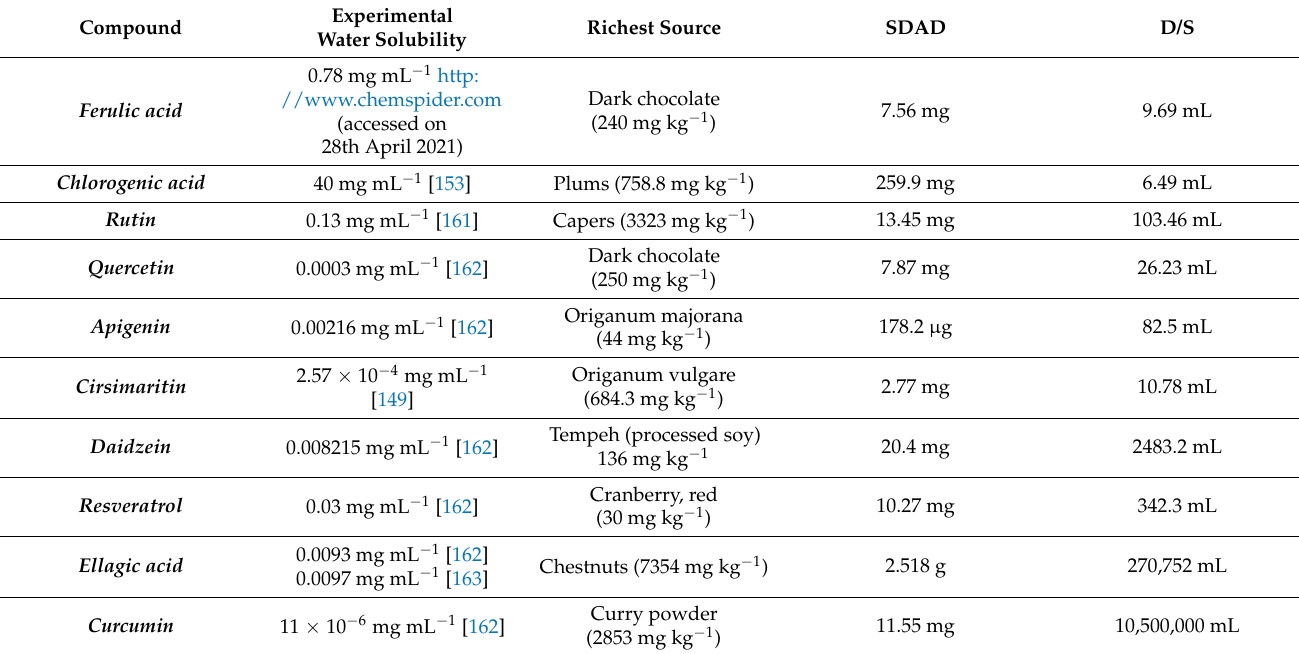
Table 2. Water solubility, sources, calculated single dietary abundant dose (SDAD), and calculated dose on solubility ratio (D/S) values of principle phenolic